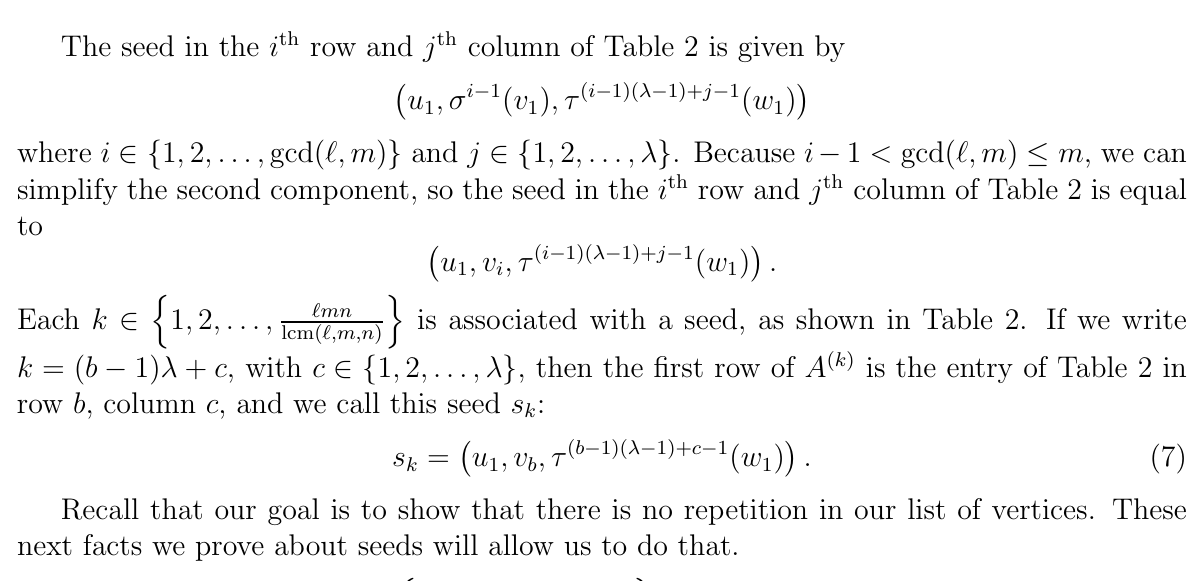
(cid:3) K (cid:3) K , with γ = gcd( (cid:96), m ) (cid:96) m n